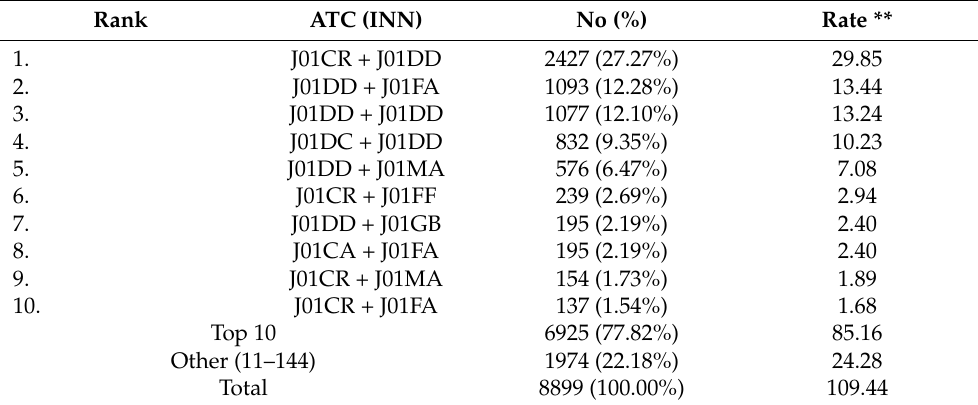
Table 2. Top ten dispensed antibiotic combinations ranked by the share of total dispensing by pharmacological subgroups (ATC4) expressed as the number of